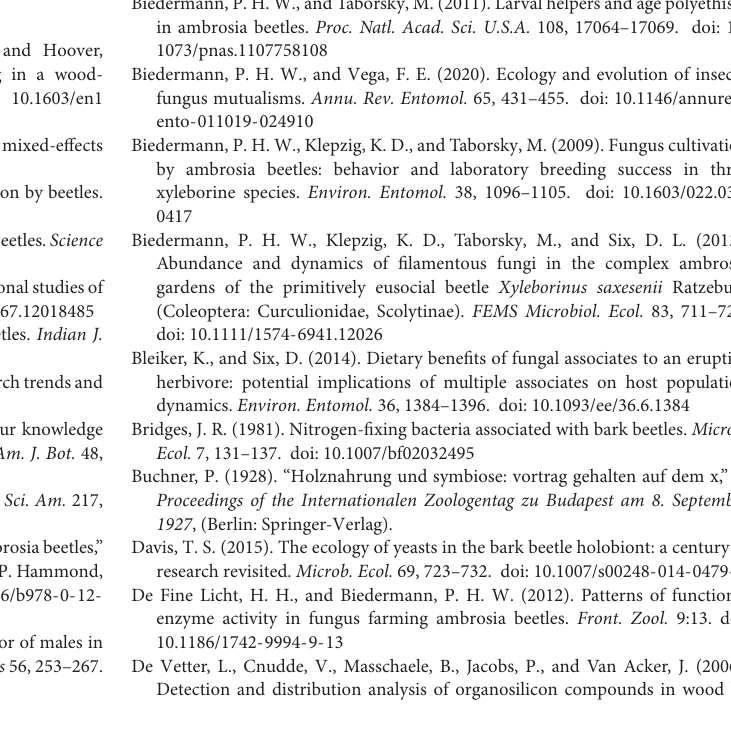
Supplementary Figure 1 | Elemental composition of gallery walls and xylem surrounding a gallery of Xyleborinus saxesenii (ID = X.sax2) using SEM-EDX. The gallery was examined in vertical (A,B) and horizontal (C,D) direction respective to wood grain; location and numbers of measured areas are given in the photos on the right. The Y -axis of each plot is counts per second (cps) per electronvolt (eV) of each element, while the X -axis is the applied electricity in kilo-electronvolt (keV). Supplementary Figure 2 | Elemental composition of gallery walls, entrance tunnel and xylem surrounding a gallery of Xyleborinus saxesenii (ID = X.sax3) using SEM-EDX. The gallery was examined in vertical (A,B) and horizontal (C–E) direction respective to wood grain; location and numbers of measured areas are given in the photos on the right. The Y -axis of each plots is counts per second (cps) per electronvolt (eV) of each element, while the X -axis is showing the applied electricity in kilo-electronvolt (keV). Supplementary Figure 3 | Elemental composition of gallery walls, pupal chambers and xylem surrounding a gallery of Trypodendron lineatum (ID = T.lin2) using SEM-EDX. Pupal chambers and surrounding xylem were examined in vertical (A–C) direction. The gallery was examined in horizontal (D,E) direction; location and numbers of measured areas are given in the photos on the right. The Y -axis of each plots is counts per second (cps) per electronvolt (eV) of each element, while the X -axis is the applied electricity in kilo-electronvolt